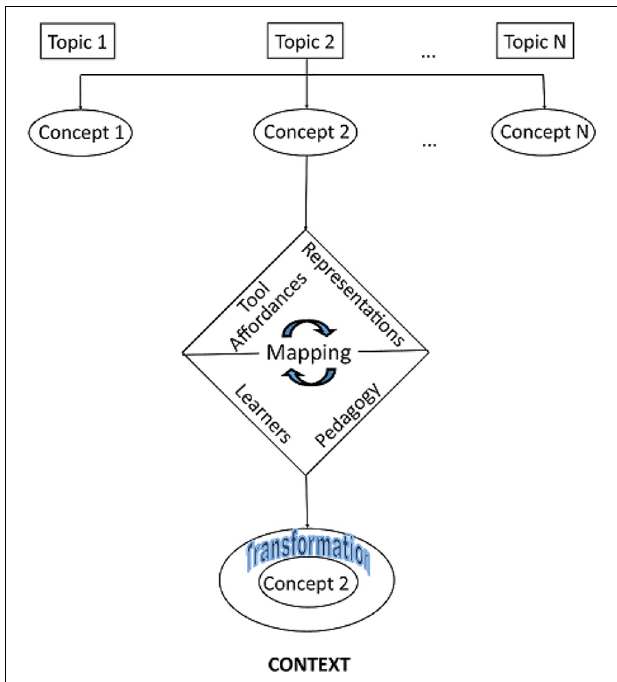
FIGURE 1 | Technology Mapping model (adopted from Angeli and Valanides,